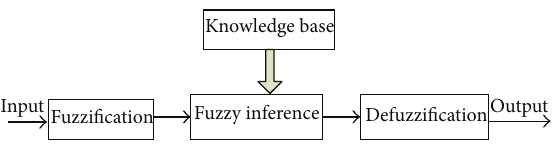
Figure 8: Fuzzy controller block